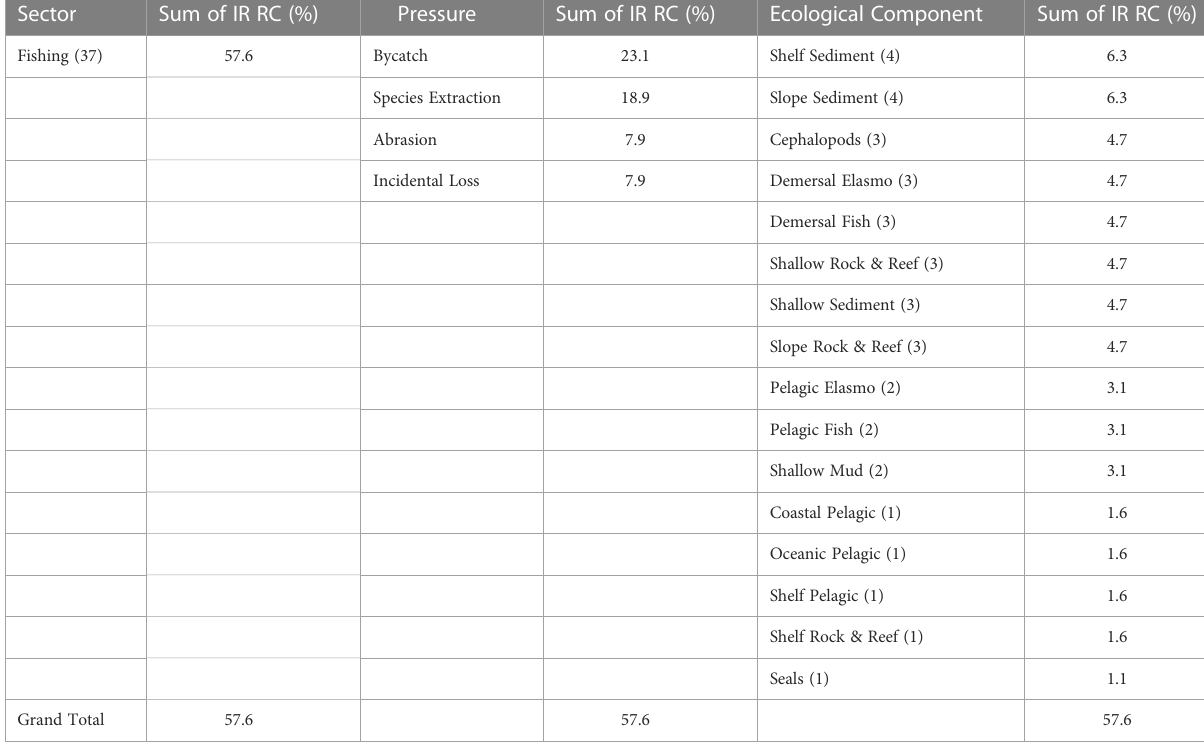
TABLE 7 Top linkage chains as identi fi ed from the Relative Contribution (RC) to Impact Risk Scores. Sector Sum of IR RC (%) Fishing